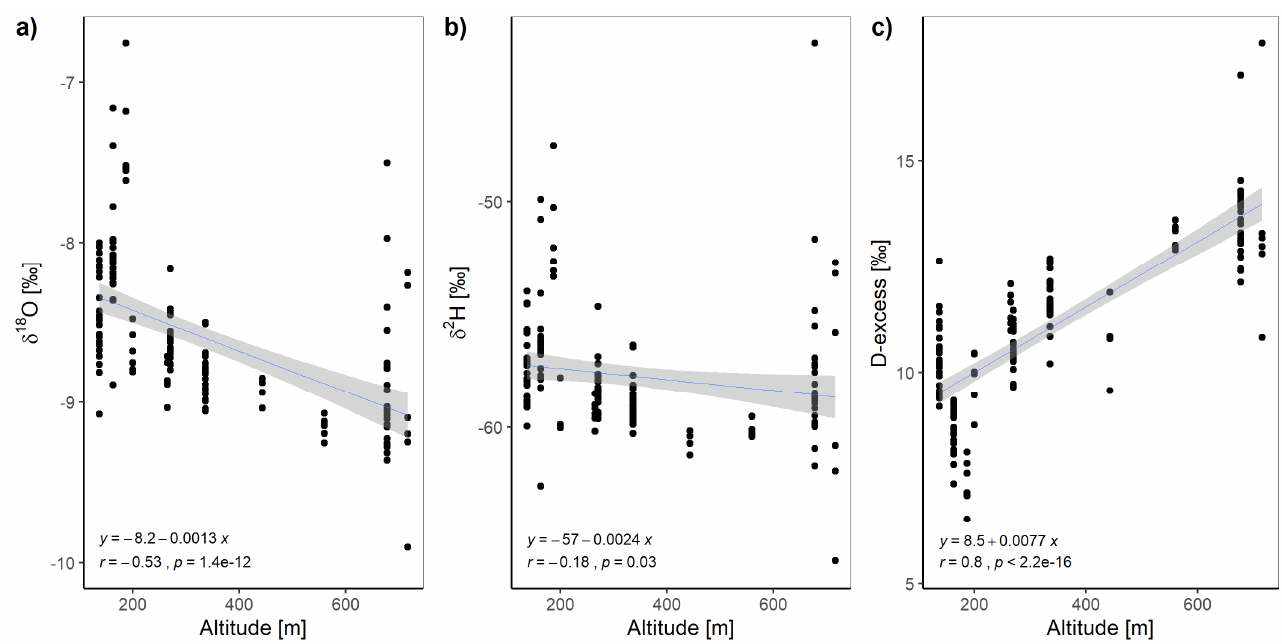
Figure 7. The isotopic values of δ 18 O ( a ), δ 2 H ( b ), and D-excess ( c ) of surface water with altitude. The grey shadings represent the 95% confidence interval of the linear regression lines.